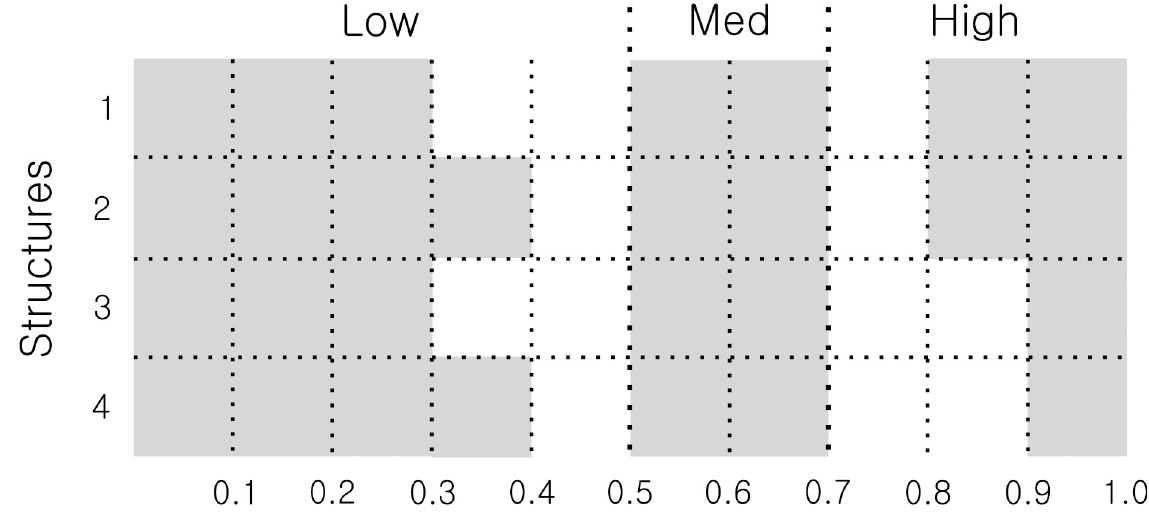
Fig 5. Symbolic translation of extended arithmetic mean = 2.40 to 2-tuple = (PA. 0.40).